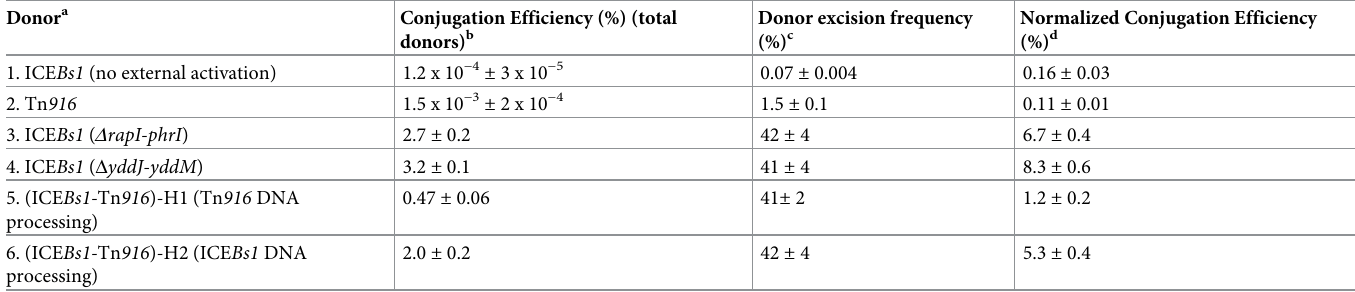
Table 1. Excision frequencies and conjugation efficiencies of ICEs. Donor